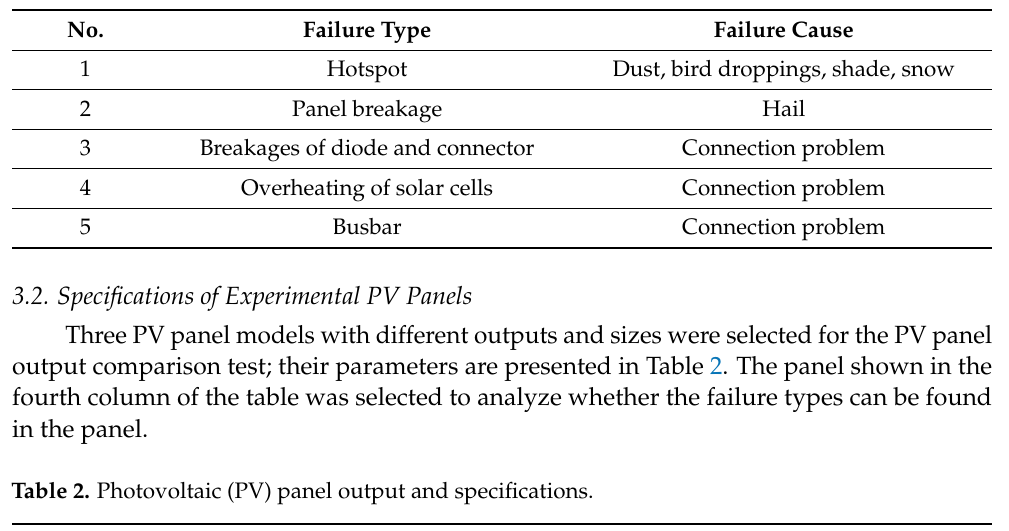
Table 1. Solar cell failure types.